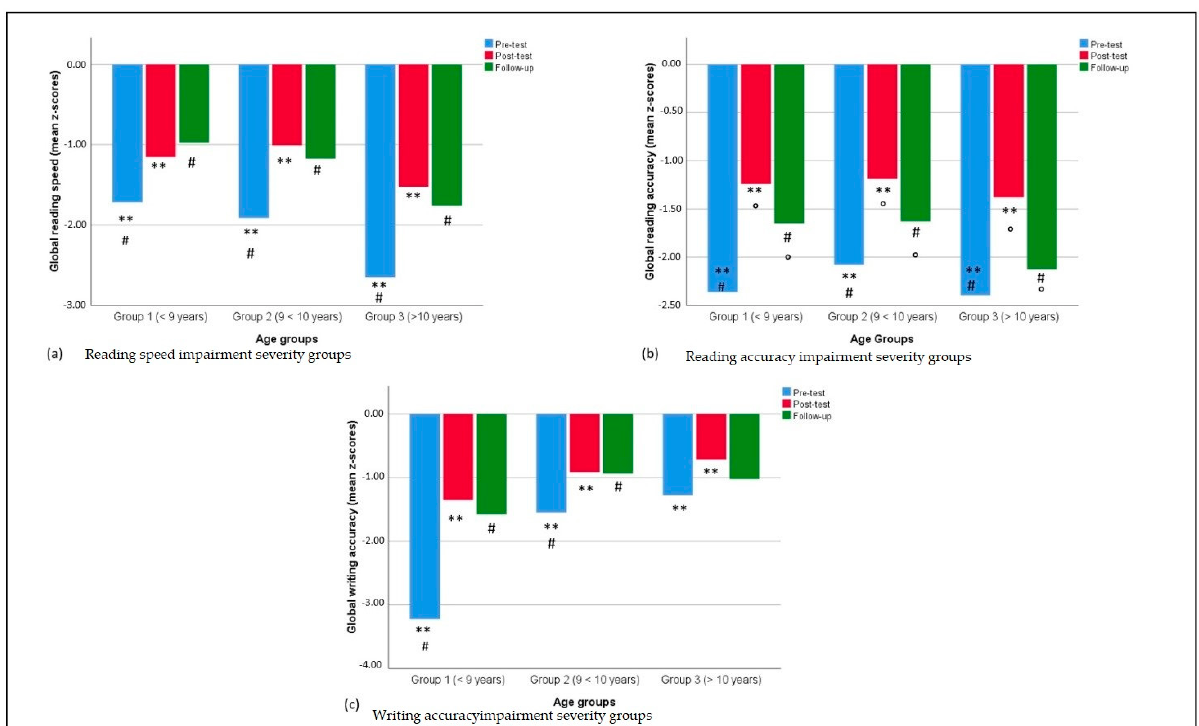
Figure 4. Pre-test, post-test, and follow-up reading and writing scores in the three different age groups. Identical symbols (**, °, #) indicate pairs of significantly different variables within each groups. Identical symbols (**, ◦ , #) indicate pairs of significantly different variables within each between-groups comparison. between-groups